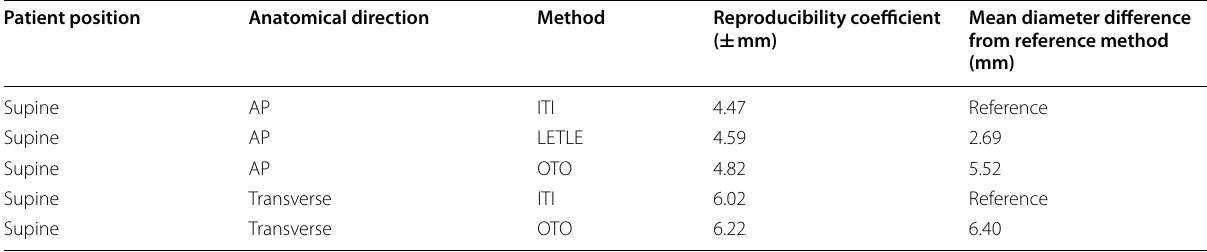
Table 3 Inter-observer reproducibility